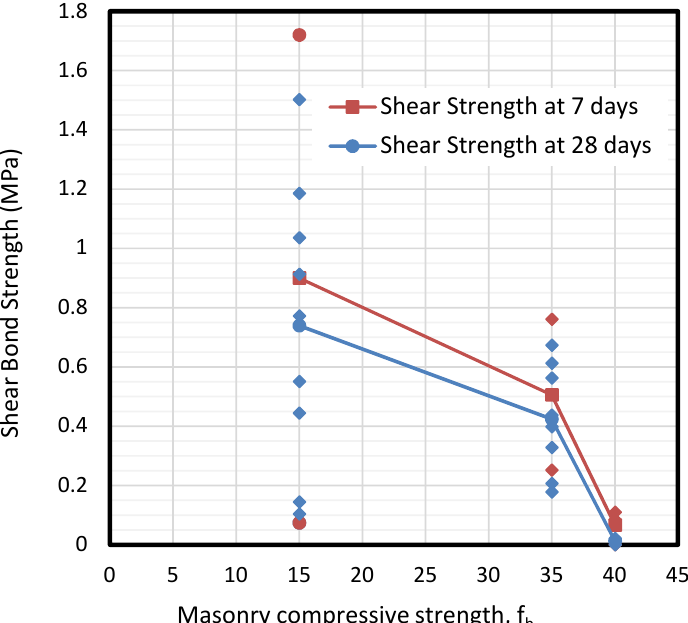
Figure 9. Calculated values of shear bond strengths depending on bricks (fb) at different ages of mortar drying.